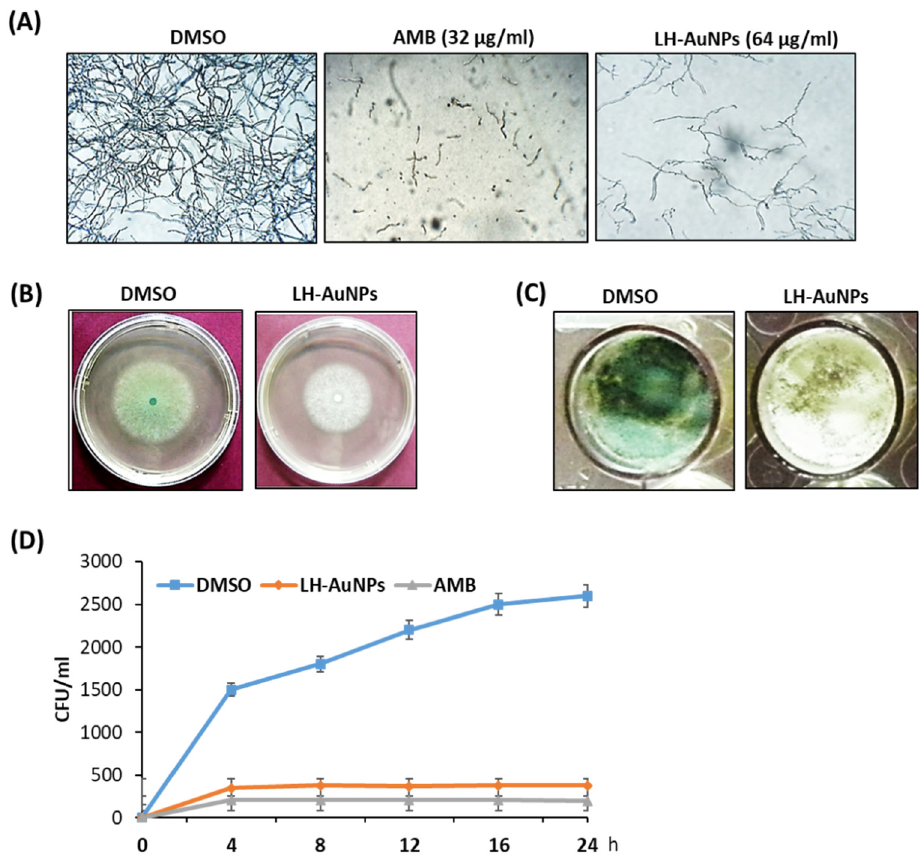
Figure 3. Antimicrobial potential of LH-AuNPs. ( A ) Inverted microscope images of A. fumigatus treated with DMSO, LH-AuNPs, and AMB at their MIC values. Visual alterations in mycelial growth are obvious at three different treatments. ( B ) Radial growth of A. fumigatus was inhibited, where LH-AuNPs reduced the relative radial growth of A. fumigatus by 30% compared to the control. ( C ) Pigment formation defects after LH-AuNPs treatment. The LH-AuNPs treated colonies lacked green pigmentation, signifying they formed few conidia. ( D ) Time–kill curves of A. fumigatus following exposure to LH-AuNPs and AMB. Values are mean ± SD of three independent experiments.